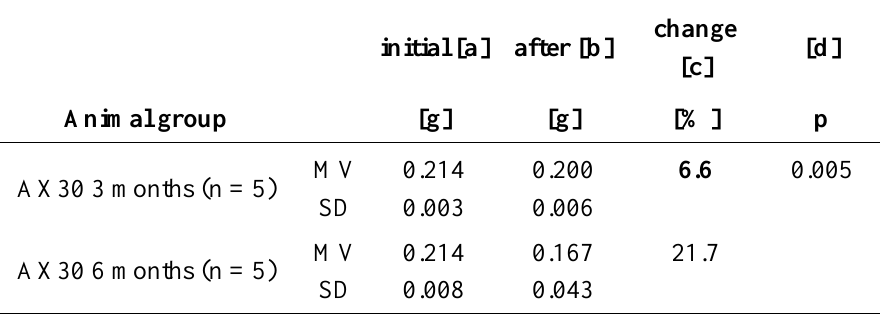
Table 3. Weights of the implants initially and after explantation and